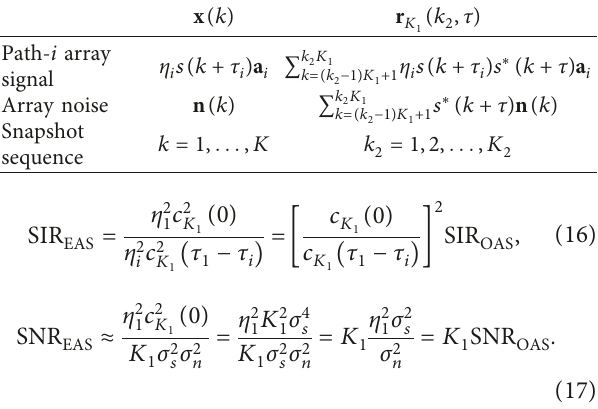
Table 3: Comparison of OAS and EAS. x ( k